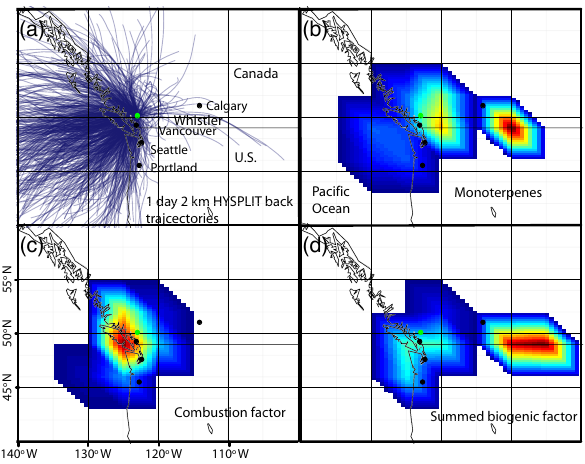
Fig. 6. Maps of British Columbia and surrounding regions show- ing (a) one day NOAA HYSPLIT back trajectories and potential sources contribution functions (PSCF) of (b) monoterpenes, (c) the combustion factor, and (d) the summed biogenic